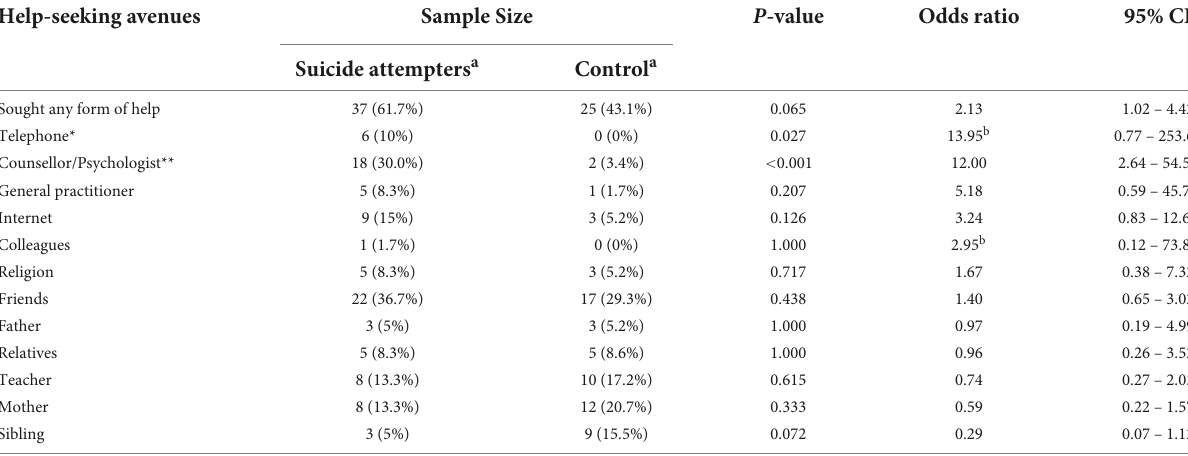
TABLE 7 Comparison of help-seeking behavior between suicide attempters and control